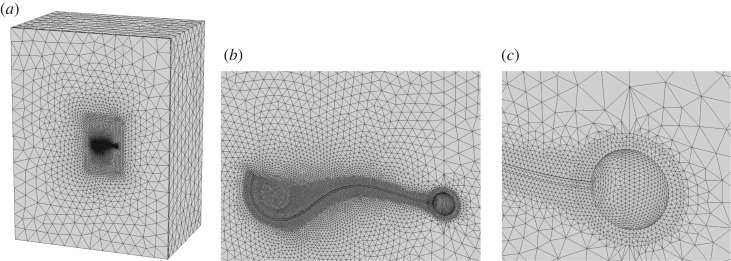
(a) Computational domain for the finite-element solution. (b) Zoomed finite-element mesh around the swimmer. (c) Zoomed finite-element mesh around the swimmer head.